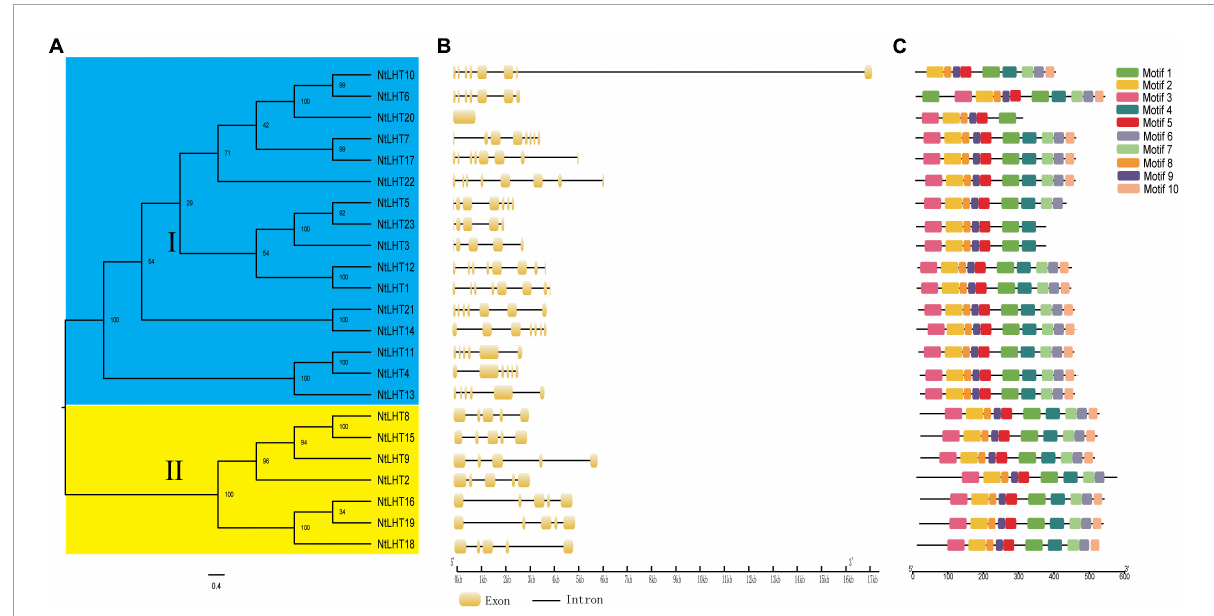
FIGURE2 Phylogenetic relationship, exon–intron structures, and conserved motifs of NtLHT gene. (A) The phylogenetic tree was constructed based on NtLHT protein sequences, different subgroups were highlighted by different colors (subgroup I in gray, subgroup II in blue). (B) Exon–intron distribution of NtLHT genes. (C) Conserved motifs analysis. Different colors represent different